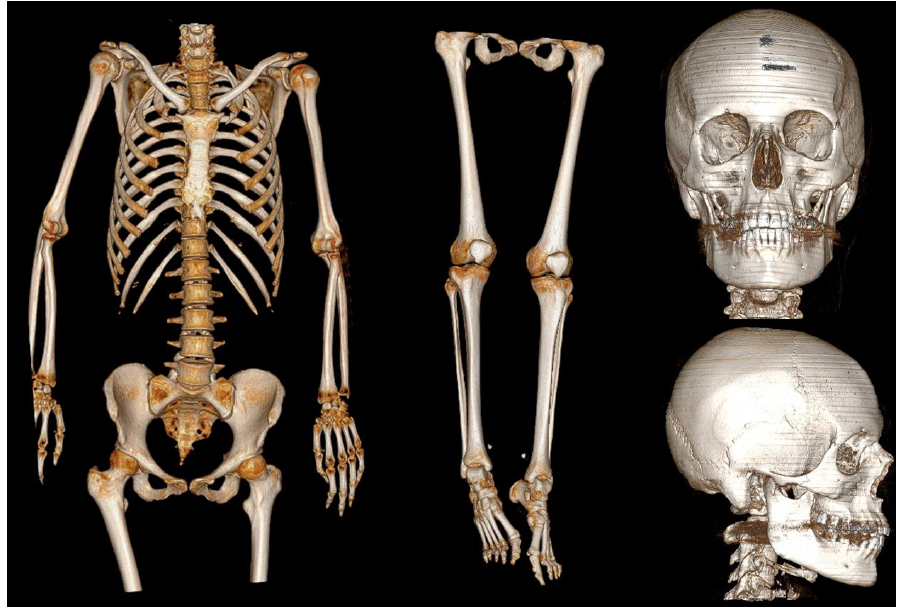
Figure 3. – 3D reconstructions of PMCT, showing no evident signs of trauma and fractures (from the left: upper body, lower limbs, frontal view of skull, lateral view of skull).